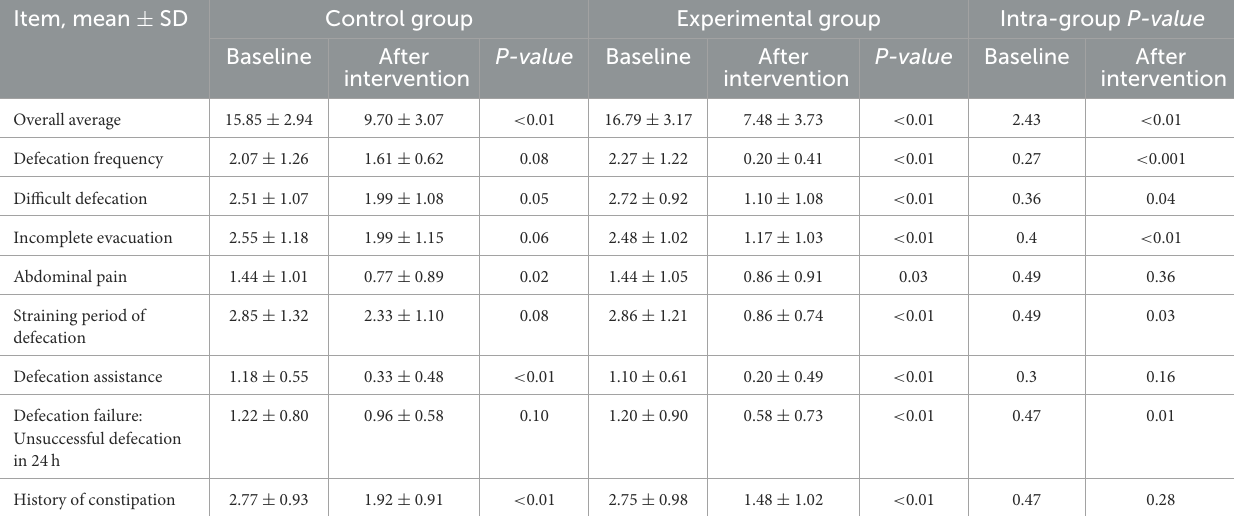
TABLE 4 Comparison of constipation symptoms before and after the interventions in CCS. Item, mean ± SD Control group Experimental group